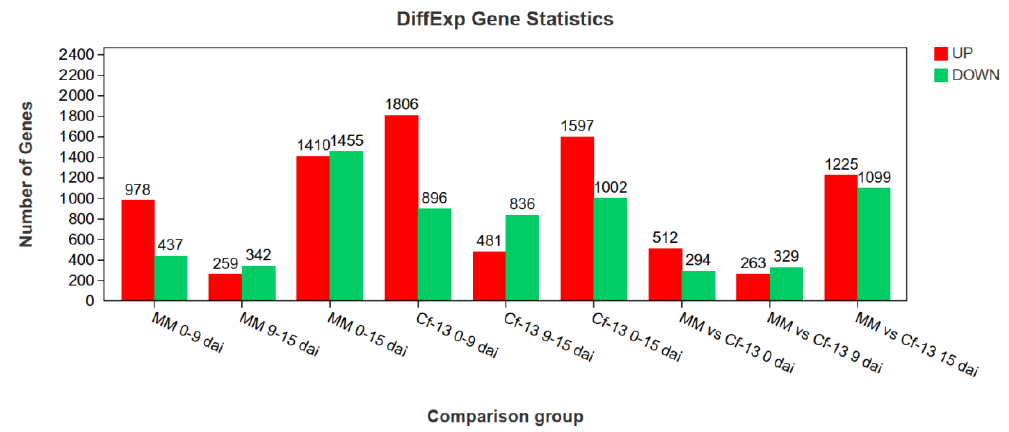
Figure 3. The DEGs among different comparison groups. 0–9 dai: comparison between 0 and 9 dai; 9–15 dai: comparison between 9 and 15 dai; 0–15 dai: comparison between 0 and 15 dai.; dai: days after inoculation.